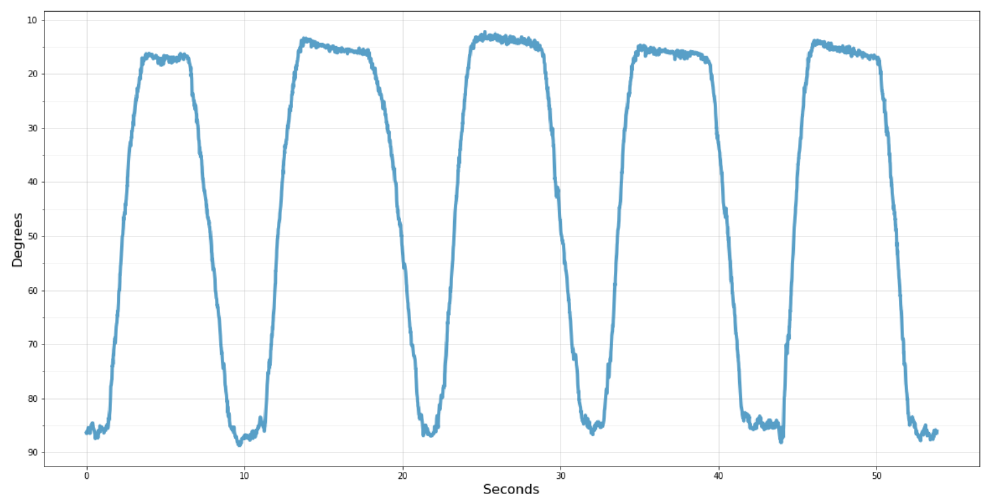
Figure 15. Knee angle acquired by the wearable